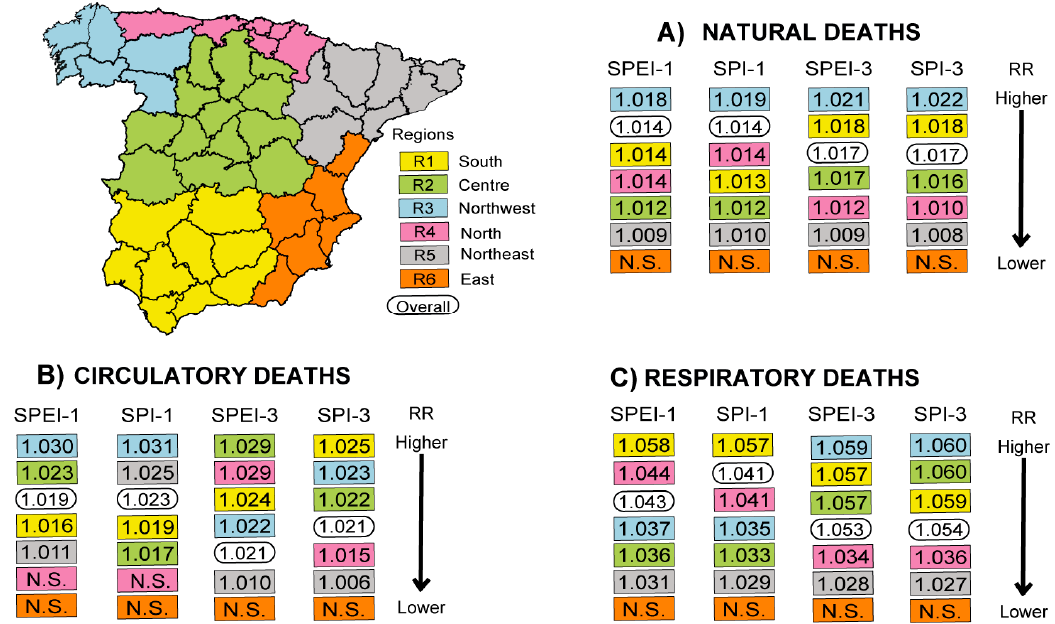
Figure 4. Combined provincial relative risk (RR) values of daily specific-cause mortality associated with drought for different spatial patterns of drought distribution and overall for peninsular Spain from 2000 to 2009, as measured by the Standardized Precipitation Evapotranspiration Index (SPEI) and the Standardized Precipitation Index (SPI) obtained for short and short—medium timescales (one and three months of accumulation, respectively). Complete statistical information is provided in the Supplementary Material (Figures S4–S6).